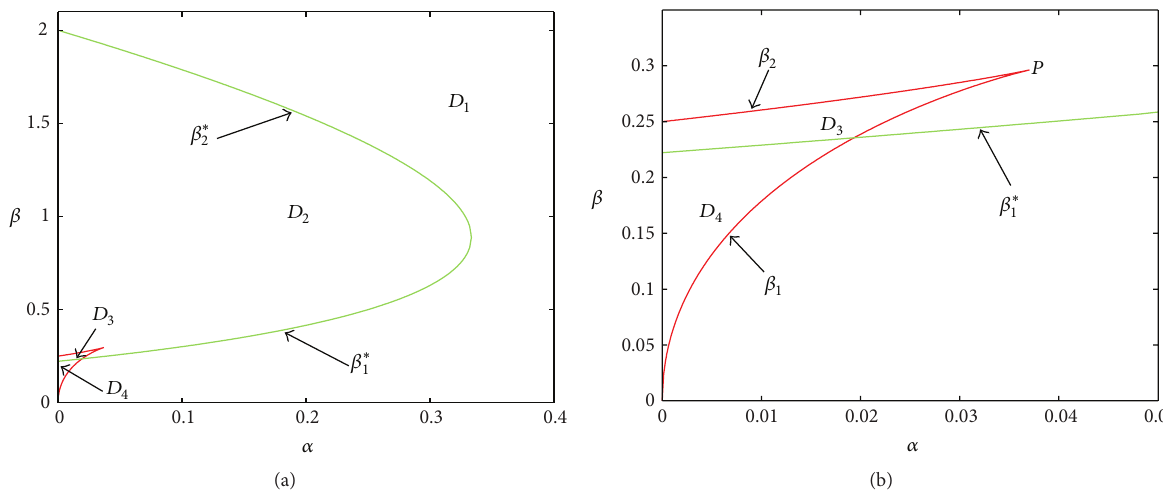
Figure 2: Bifurcation diagram of positive equilibrium in the 𝛼 - 𝛽 plane. System (7) has three positive equilibria in the inner region enclosed by the curves 𝛽 1 and 𝛽 2 , a unique positive equilibrium outside this region and on the point 𝑃(1/27, 8/27) and two positive equilibria on the two curves on the boundary curves 𝛽 1 and 𝛽 2 except the point 𝑃(1/27, 8/27)